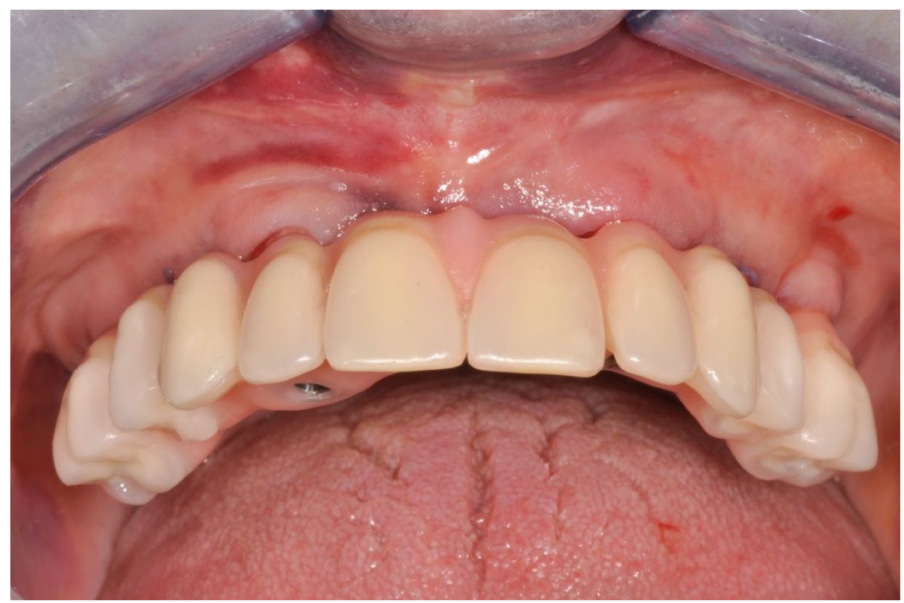
Figure 5. Interim prosthesis after implant